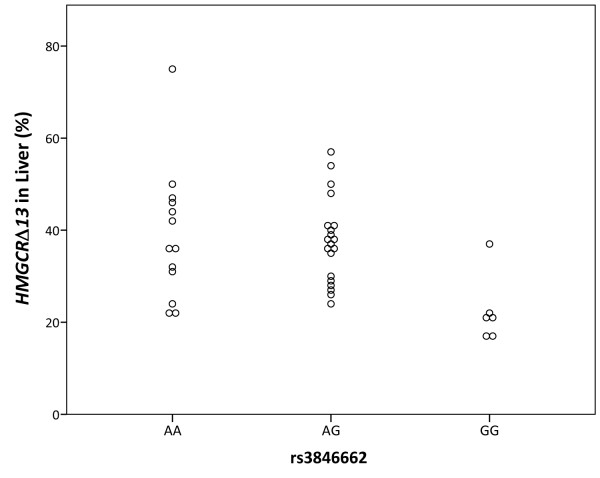
Rs3846662 is significantly associated with percent HMGCRΔ13 in human liver. Individuals homozygous for the G allele of rs3846662 exhibit the most efficient splicing of HMGCR exon 13 (p = 0.026, ANOVA. We note that GG homozygotes also exhibit an increased risk of AD and exhibit increased total and LDL cholesterol.